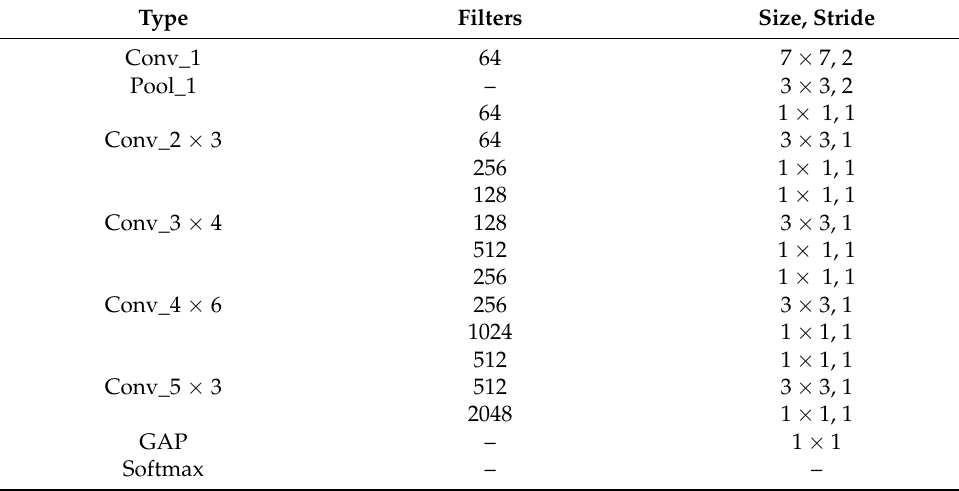
Figure 5. Architecture of the ResNet50. Table 2. Layer description of